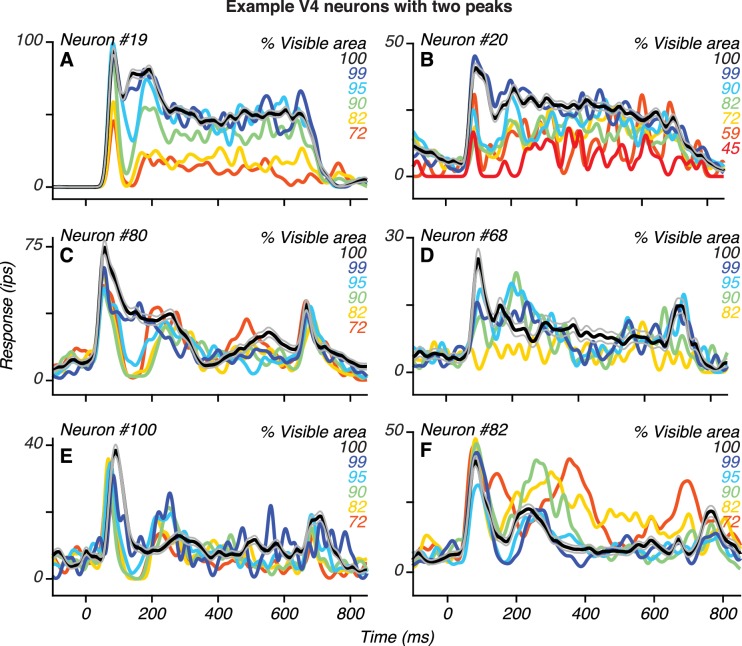
Additional examples of V4 neurons with two peaks.For each neuron, there was a statistically significant increase in response at the time of the second peak relative to the preceding trough (t Test, p<0.05, Bonferroni corrected).